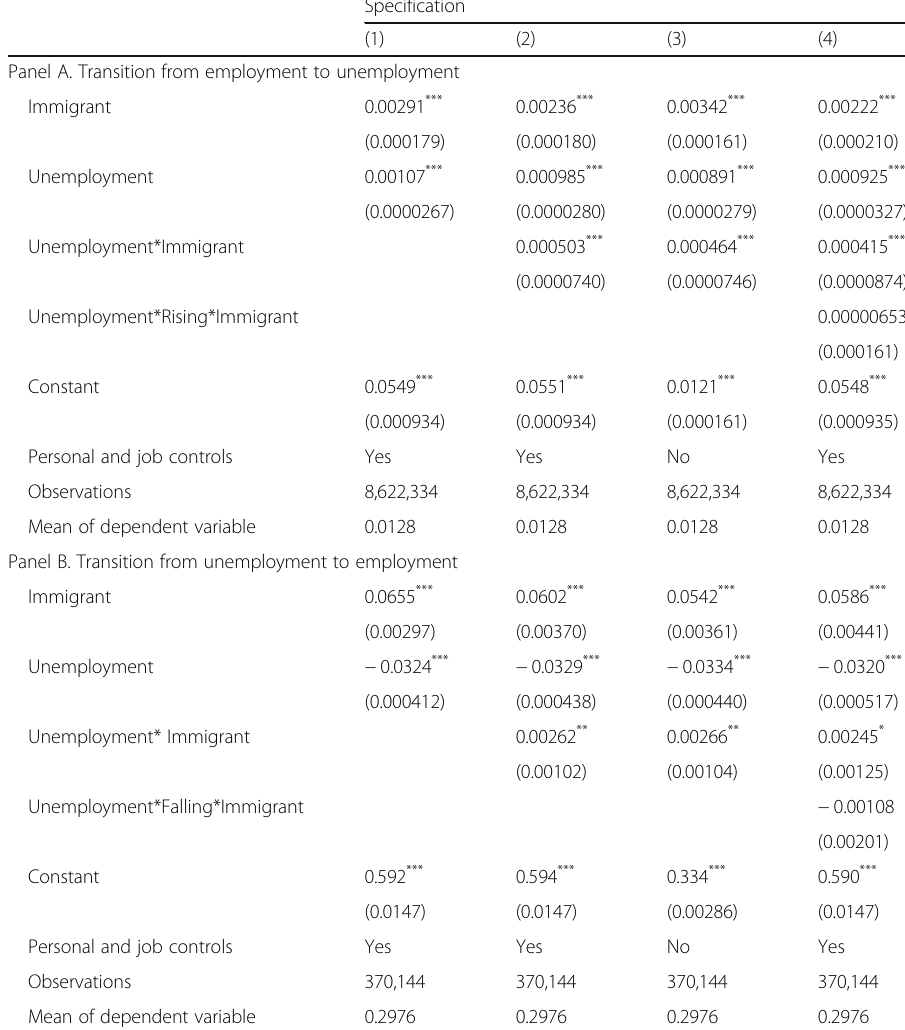
Table 3 Two-way transitions between employment and unemployment: matched CPS data, 1996 –